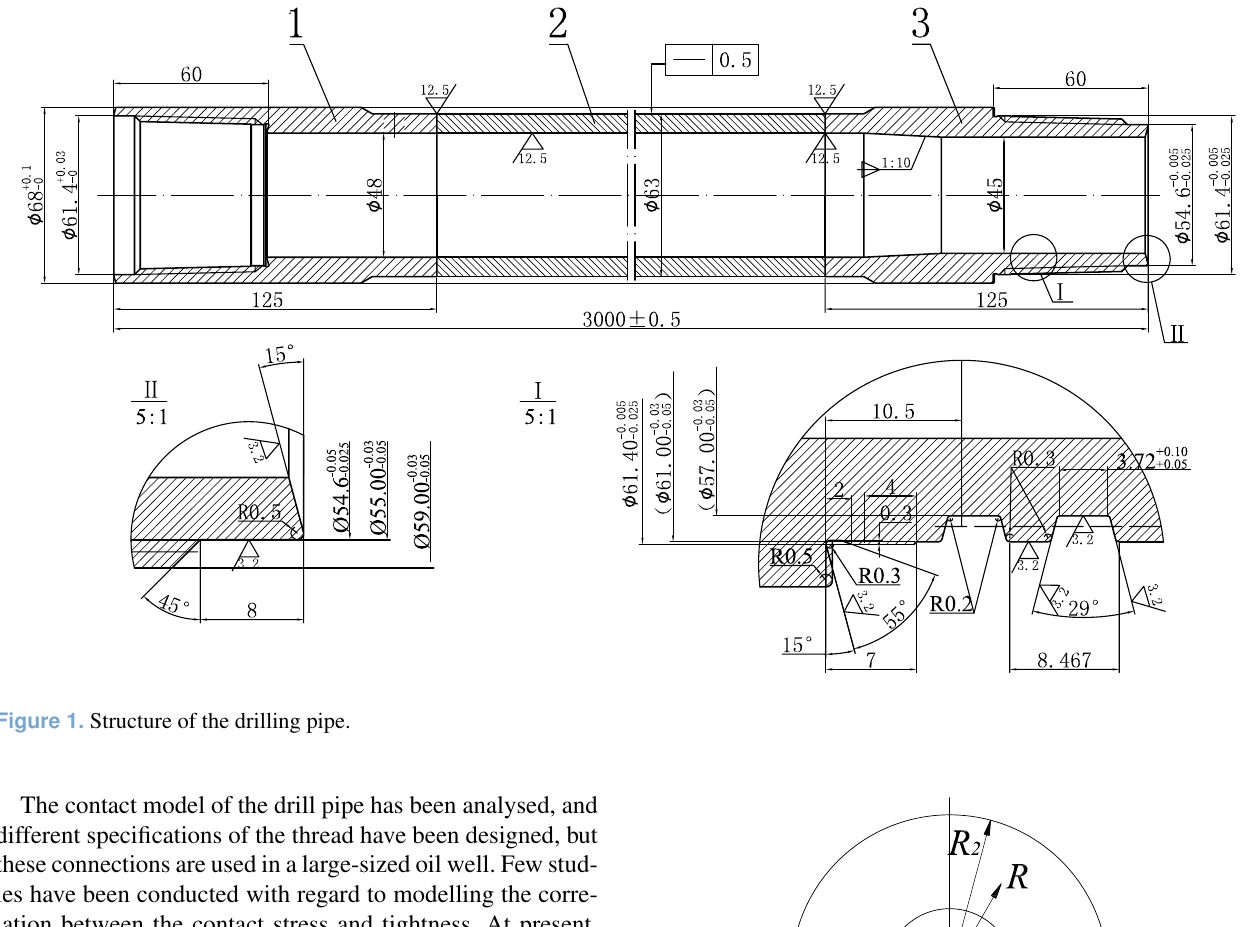
Figure 1. Structure of the drilling pipe.